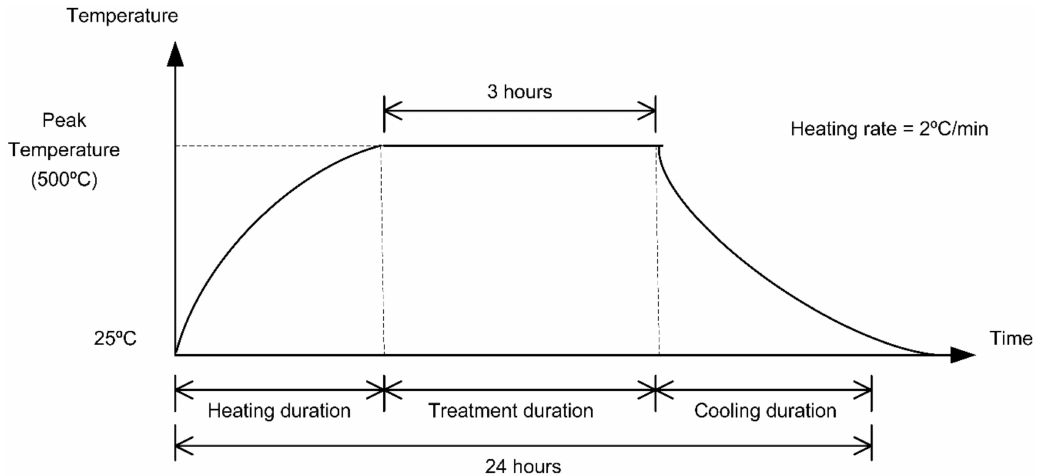
Figure 2. A schematic heating profile of the tested concrete